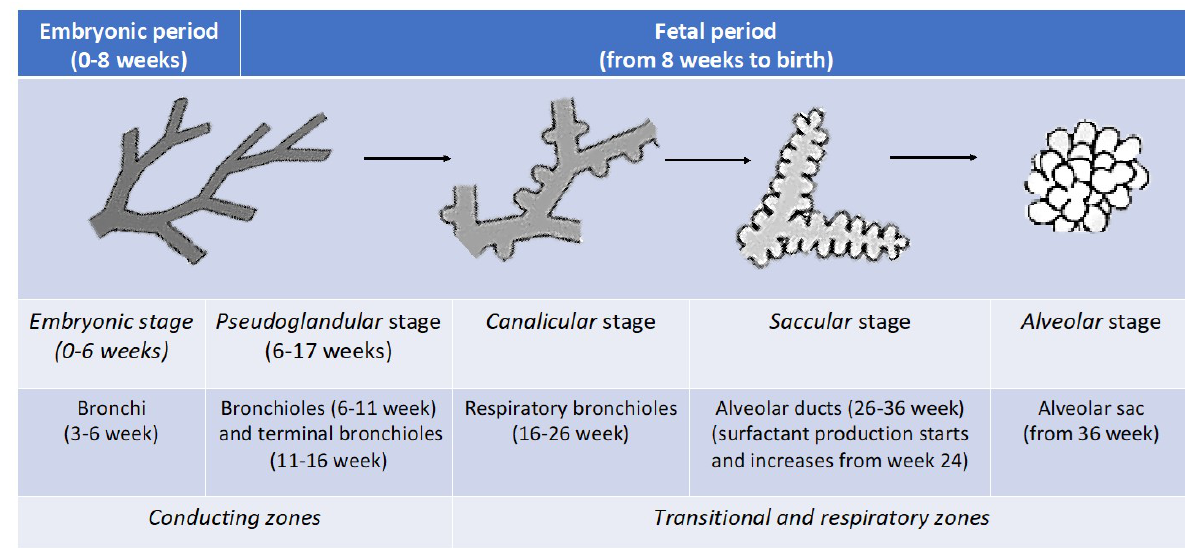
Figure 1. Five different stages of lung